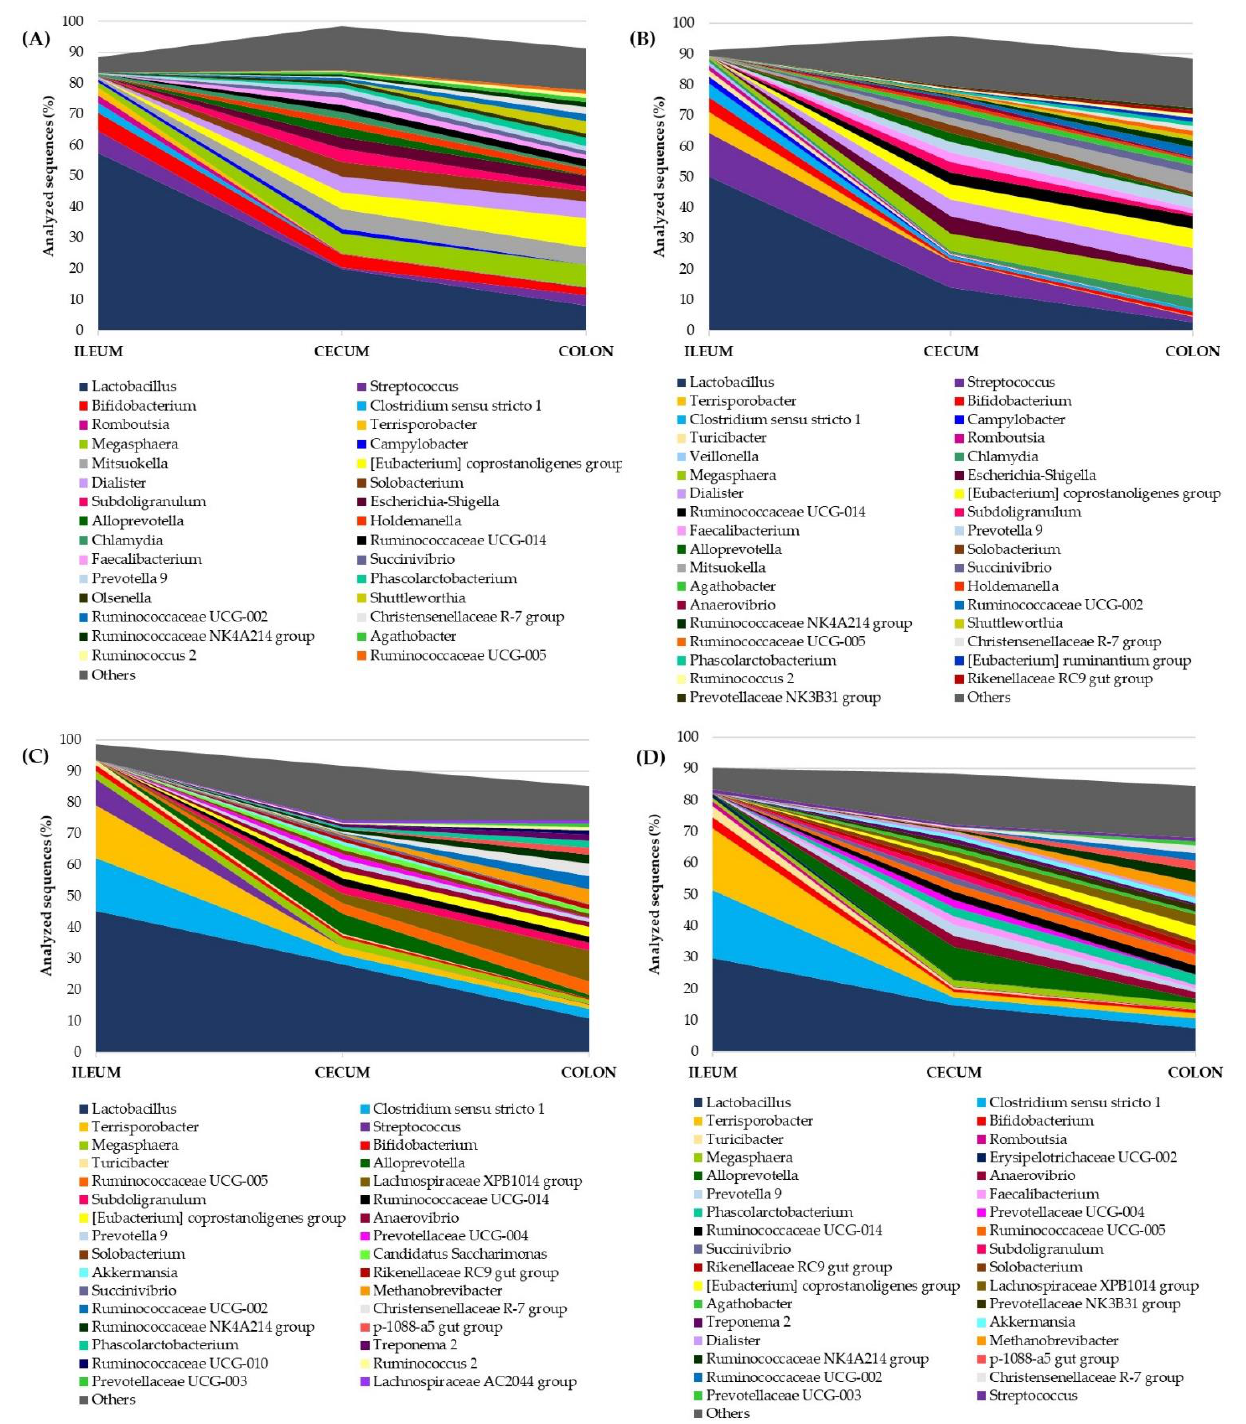
Figure 1. Genera abundance throughout the intestinal tract in ( A ) growing Duroc pigs (26.4 kg), ( B ) growing F2 pigs (31.6 kg), ( C ) fattening Duroc pigs (85.1 kg) and ( D ) fattening F2 pigs (91.1 kg). Low-abundance genera (<1% analyzed sequences) are represented as “Others”.